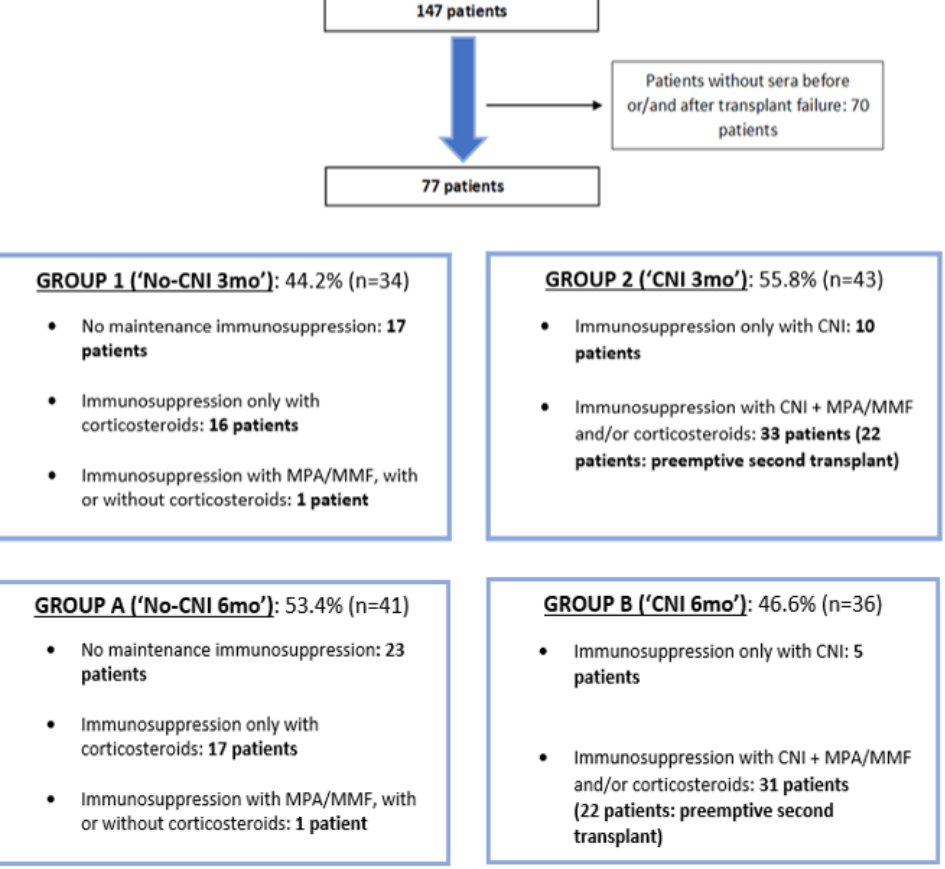
Figure 1. Subject selection and patient groups according to maintenance immunosuppression until the third (group 1 and 2) and sixth month (group A and B) after transplant failure.